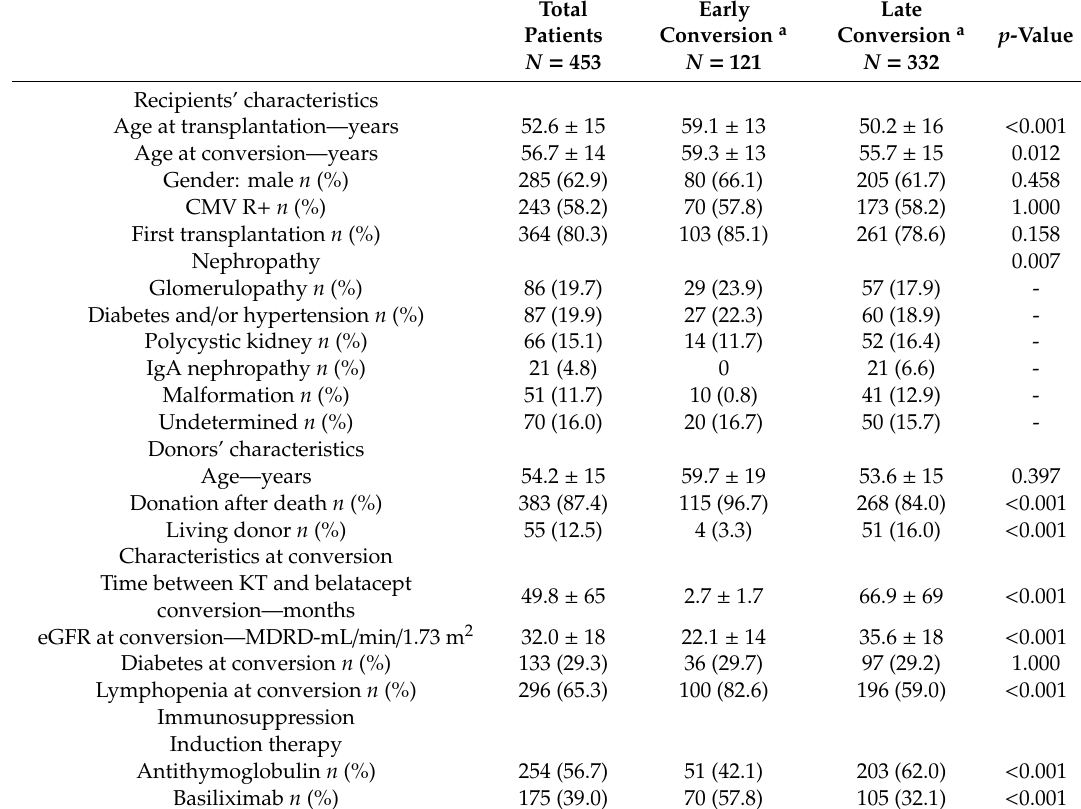
Table 1. Baseline characteristics of patients converted to